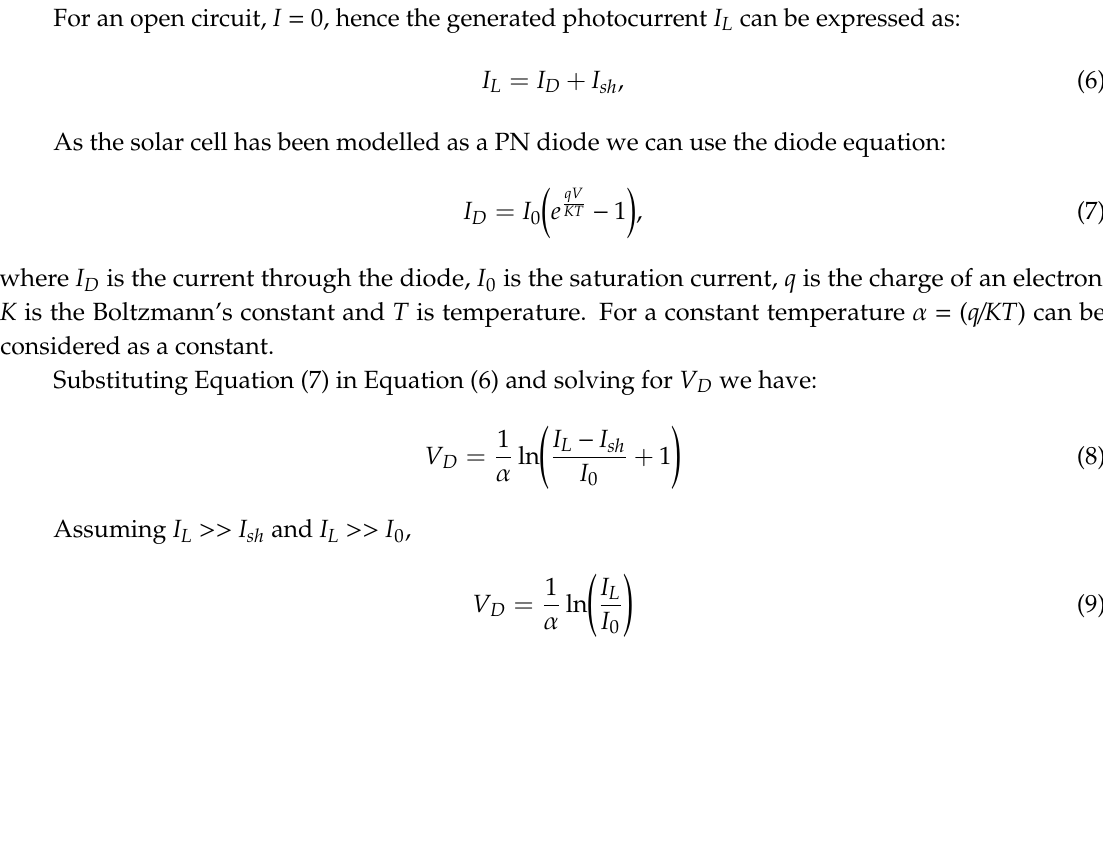
Figure 4. Single-diode model of a solar cell for energy harvesting.